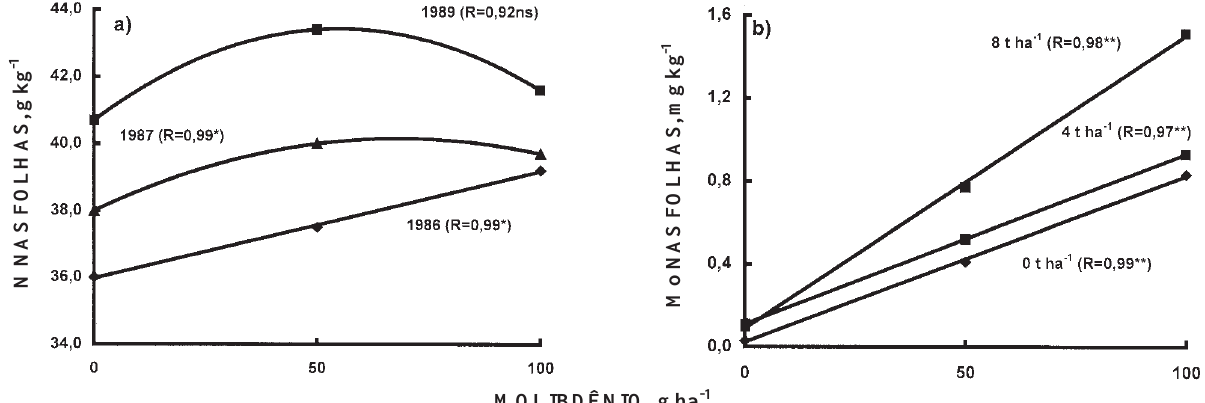
Figura 5. Influência do molibdênio sobre (a) os teores de nitrogênio e (b) os teores de molibdênio nas folhas de soja (IAC